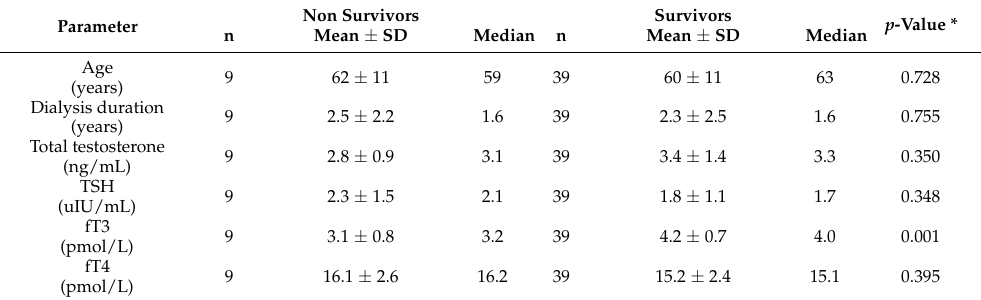
Table 3. Comparison between the group of men who died and the rest of the male dialysis patients in terms of age, dialysis duration, and the concentration of hormones in the blood serum.